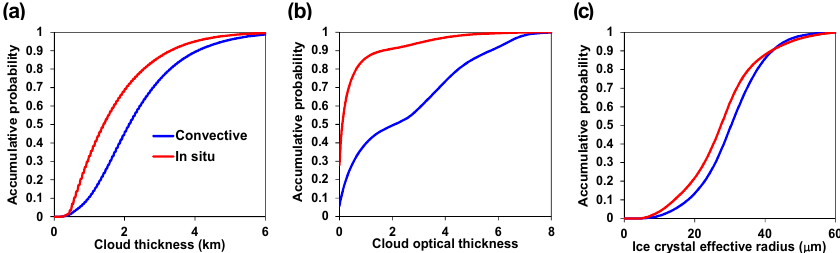
Figure 2. Accumulative probability distribution of the properties of two ice cloud types: (a) cloud thickness, (b) cloud optical thickness, and (c) R ei .